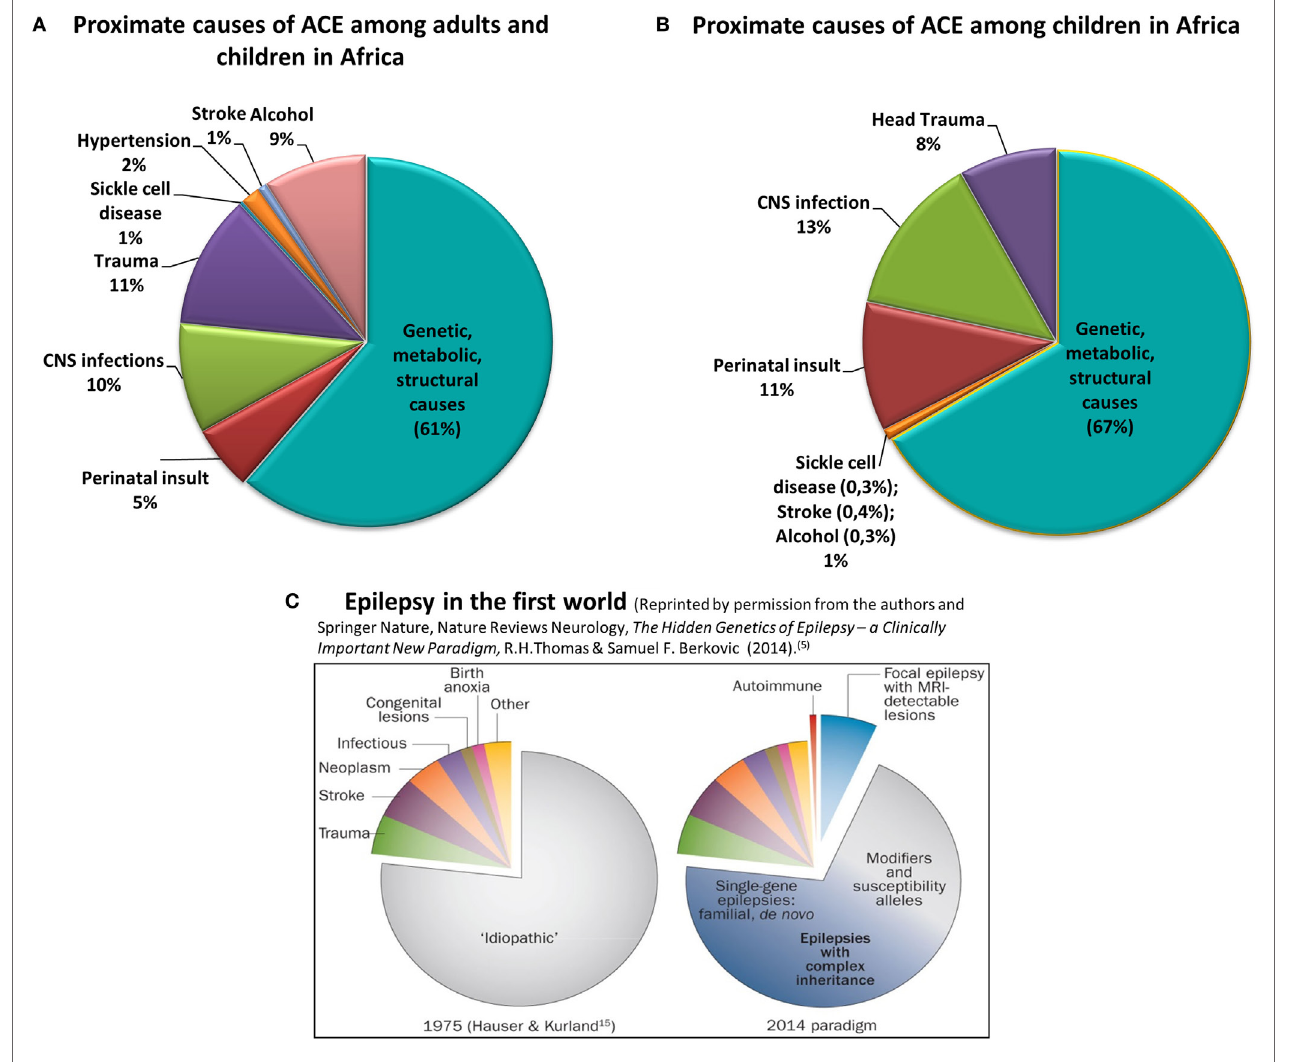
FiGUre 1 | Proximate causes of active convulsive epilepsy (ACE) in Africa according to currently available knowledge. Charts (A,B) depict the distribution of proximate causes of ACE among all ages (A) and among children in Africa (B) [data obtained from Kariuki et al. (3) and personal communication with coauthors]. Chart (c) reflects the causes of all epilepsies in the first-world environment (5). Charts (A–c) clearly show the significantly higher burden of epilepsy due to central nervous system infections, trauma, and perinatal insult in Africa, particularly among children. Also emphasized is the absence of reliable knowledge on the burden of the genetic, metabolic, and structural causes of epilepsy in Africa.